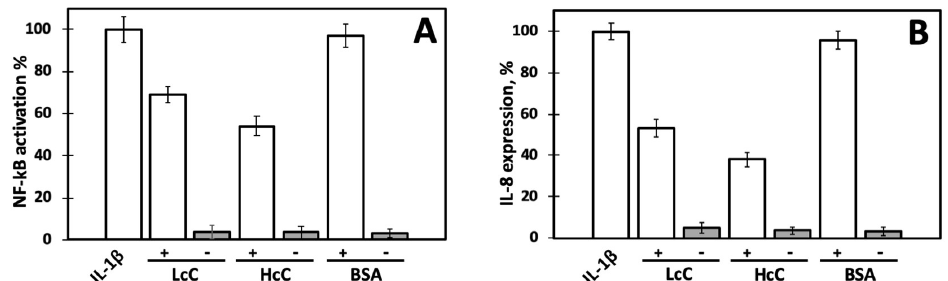
Figure 3. Inflammatory response of Caco-2 cells elicited by treatment with IL-1 β alone and incubated with 0.5 mg / mL of LcC, HcC, or BSA with ( + ) or without ( − ) IL-1 β . LcC or HcC and IL-1 β were added to the cell growing medium at the same time. Response to IL-1 β alone was set as 100%. See text for experimental details. ( A ) NF-kB activation percentage of transfected cells. ( B ) IL-8 expression percentage.